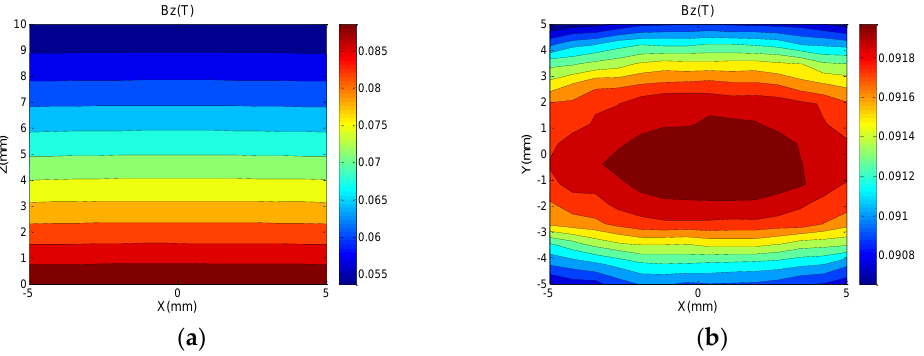
Figure 5. ( a ) Measured value magnetic field distribution in the area of 10 mm × 10 mm on XOZ plane y = 0 mm of ROI. ( b ) Measured value magnetic field distribution in the area of 10 mm × 10 mm on XOY plane z = 0 mm of ROI.